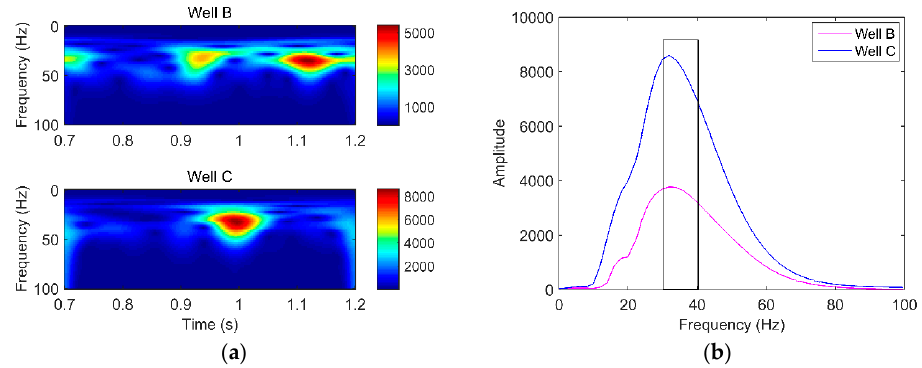
Figure 7. ( a ) Time-frequency spectra of well B and C; ( b ) the energy absorption analysis curve of well B and C at the reservoir interval.